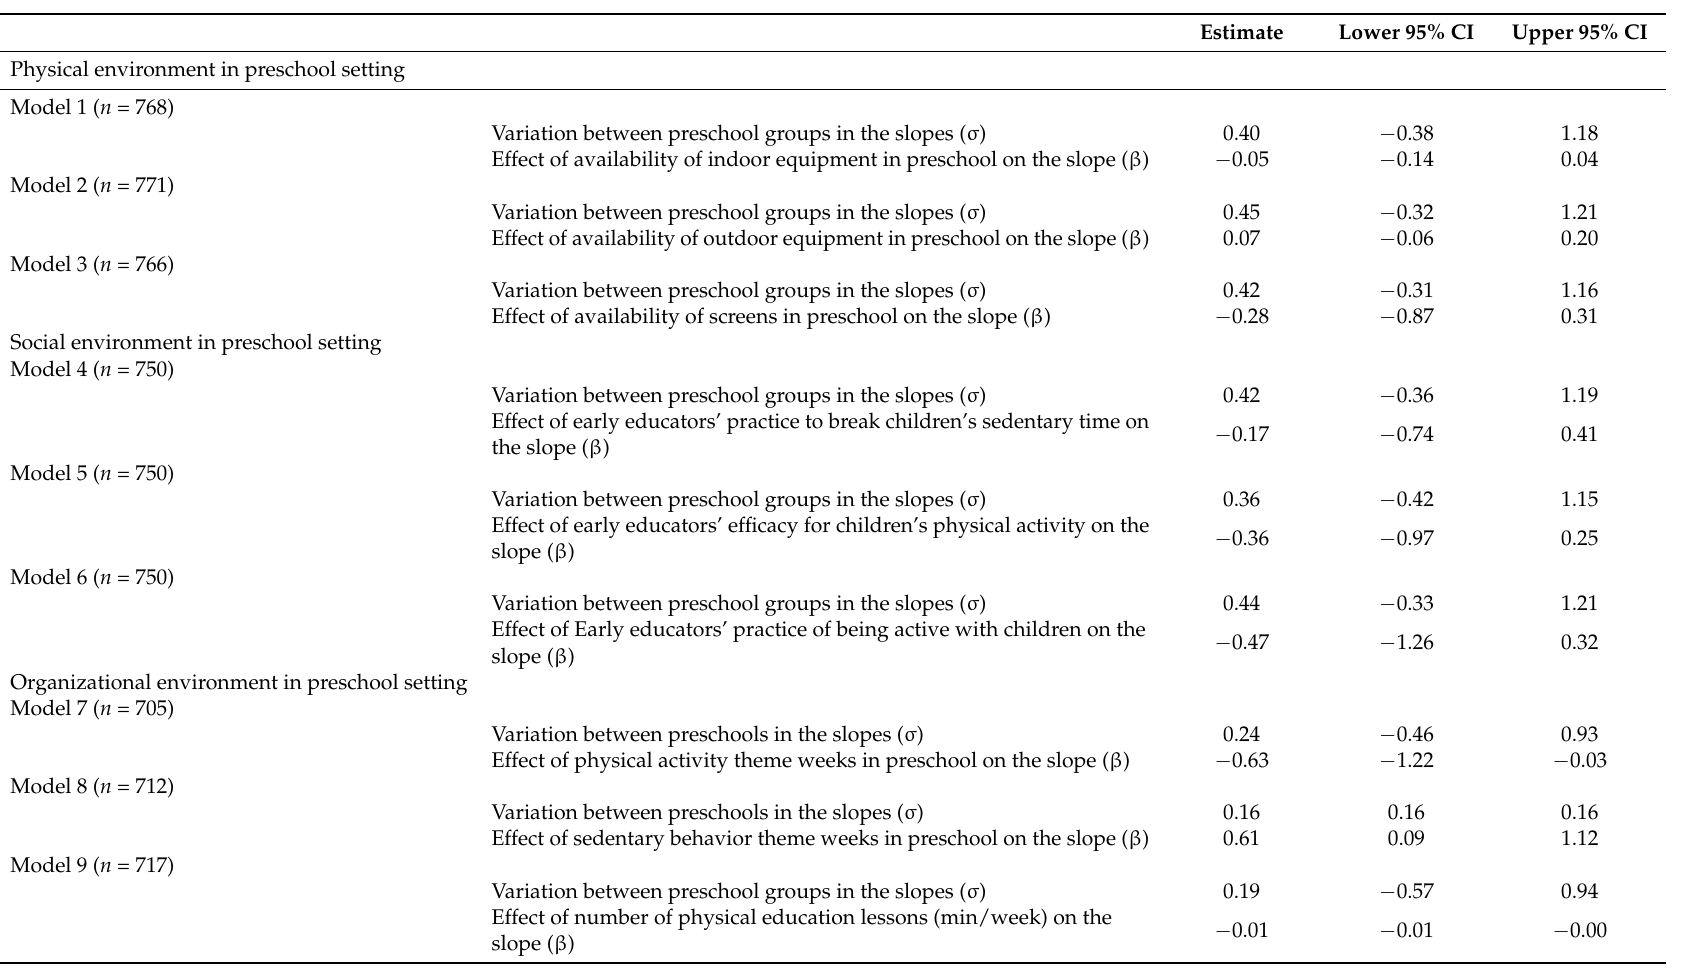
Table 3. Effects of preschool environmental factors on the slope of socioeconomic status–children’s sedentary time